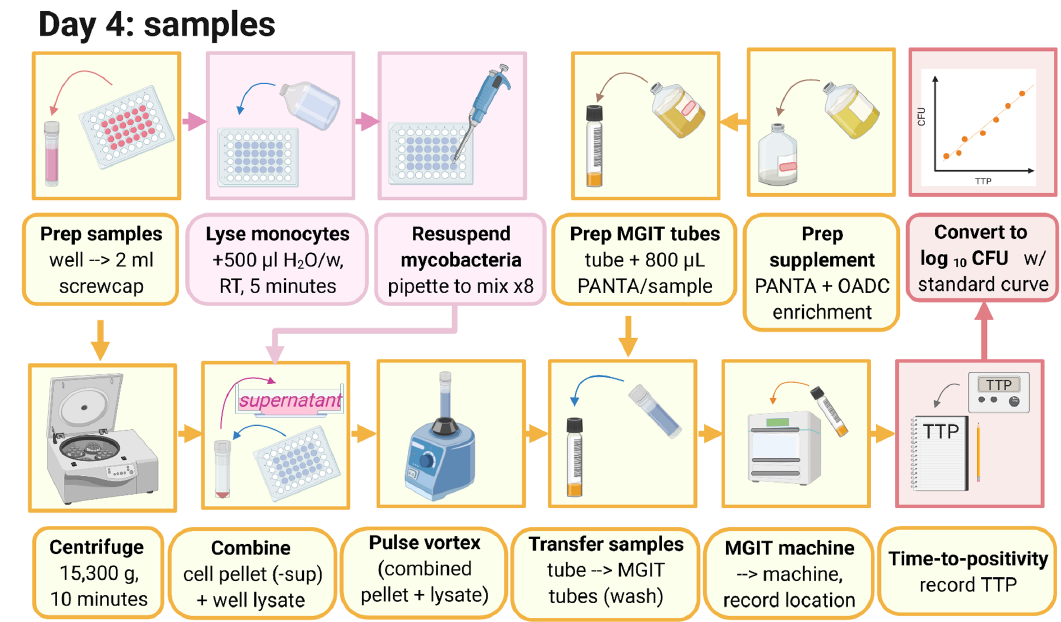
Figure 4. Day 4 MGIA processing (created with